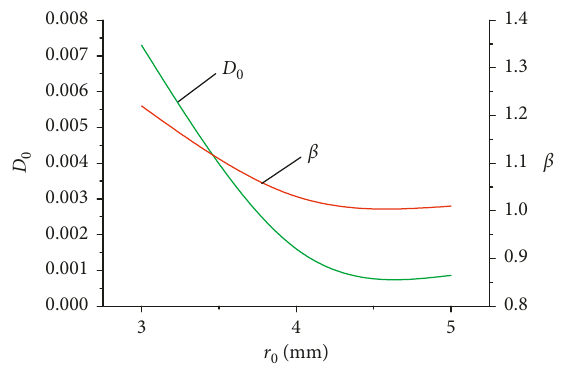
Figure 13: Surrounding rock damage of granite specimen groups and variation of ratio with the center hole